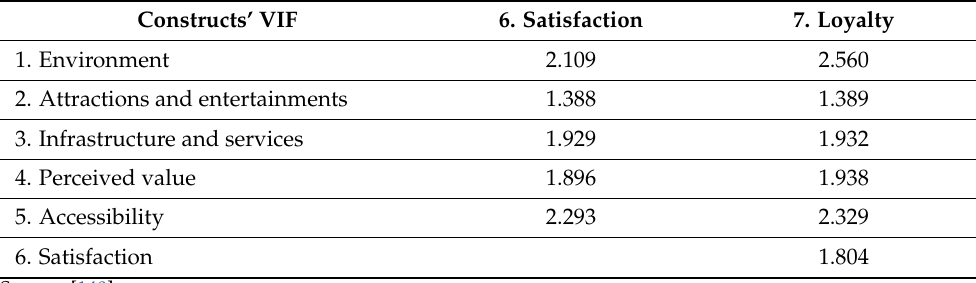
Table 5. Variance inflation factor (VIF).